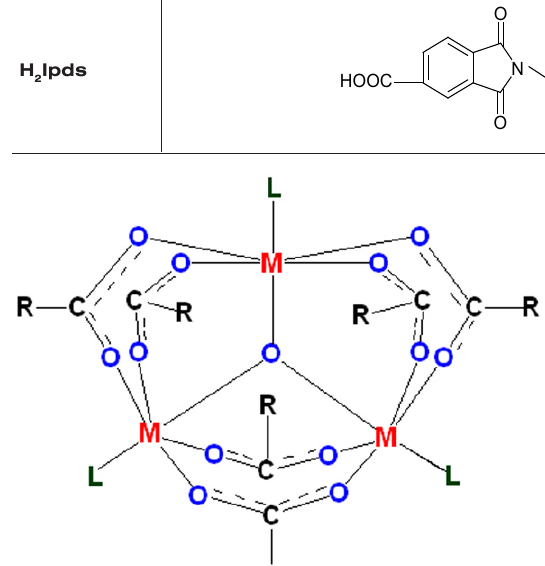
-oxo-carboxy-clusters, [ M µ 3 3d metals